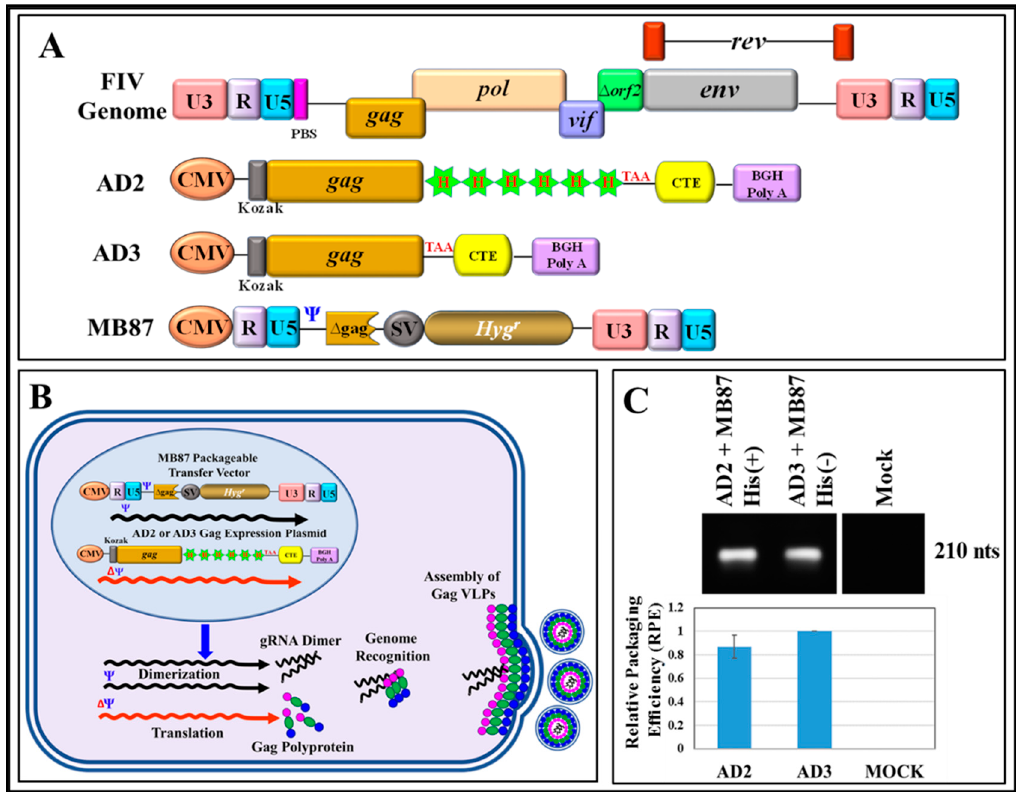
Figure 1. In vivo genetic complementation assay to assess the expression of a full-length feline immunodeficiency virus (FIV) Pr50 Gag protein, both with and without His 6 -tag, resulting in the release of virus-like particles (VLPs) that can package FIV sub-genomic RNA. ( A ) Schematic representation of the FIV genome, FIV full-length eukaryotic Gag expression plasmids with His 6 -tag (AD2) and without His 6 -tag (AD3), and the FIV sub-genomic transfer vector, MB87 [36] serving as a source of packageable RNA. ( B ) Graphical representation of the design of the genetic complementation assay. Following co-transfection of the transfer vector MB87 with either of the Gag-expression vectors (AD2 and AD3) in 293T cells should result in production of VLPs containing MB87-specific RNA due to the presence of the packaging signal ( Ψ ) on the vector. ( C -upper panel) RT-PCR amplification of MB87, an FIV-based transfer vector RNA, packaged by VLPs from His 6 -tag ( + ) and His 6 -tag ( − ) Gag clones from a representative experiment. ( C -lower panel) The relative packaging e ffi ciency (RPE) of the FIV-based transfer vector (MB87) RNA by VLPs produced by Gag expression plasmids either with His 6 -tag (AD2) or without His 6 -tag (AD3), as measured by quantitative real time RT-PCR (qRT-PCR) conducted in triplicates.